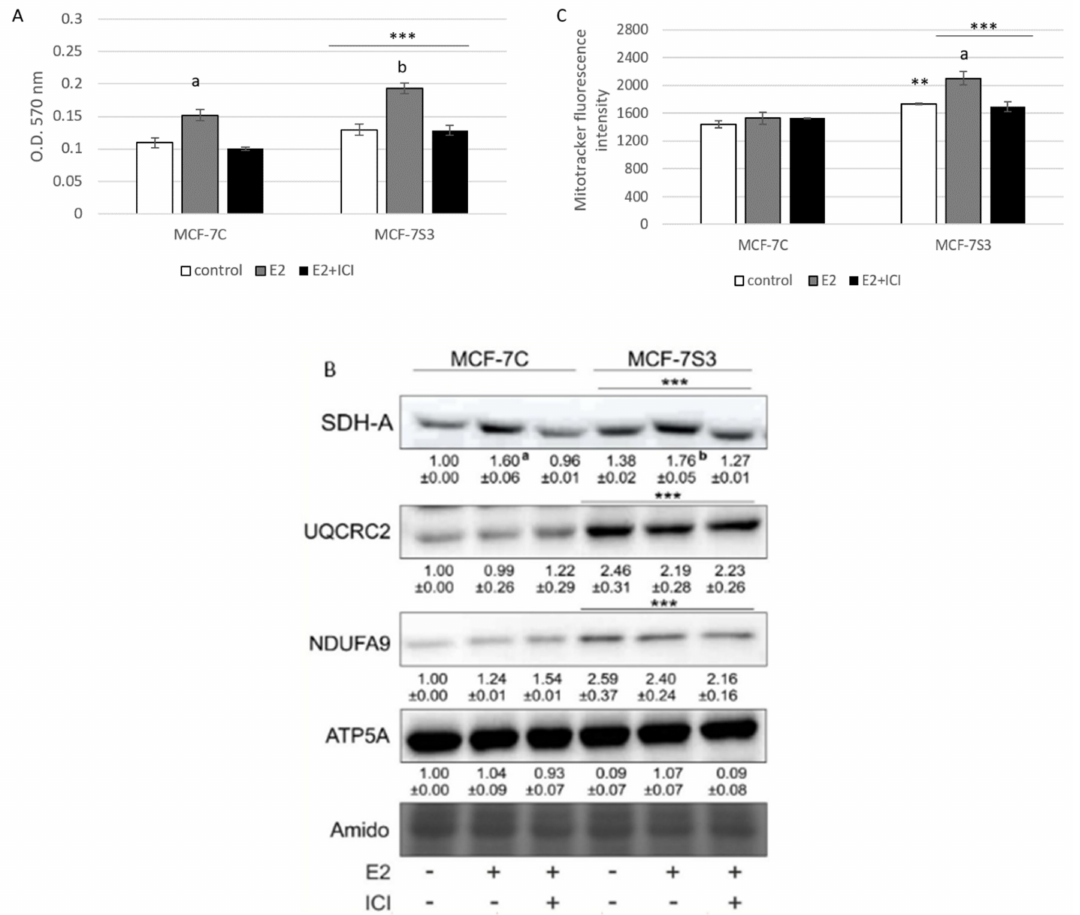
Figure 3. Sirt3 amplifies E2-induced metabolic activity and mitochondrial fitness of MCF-7